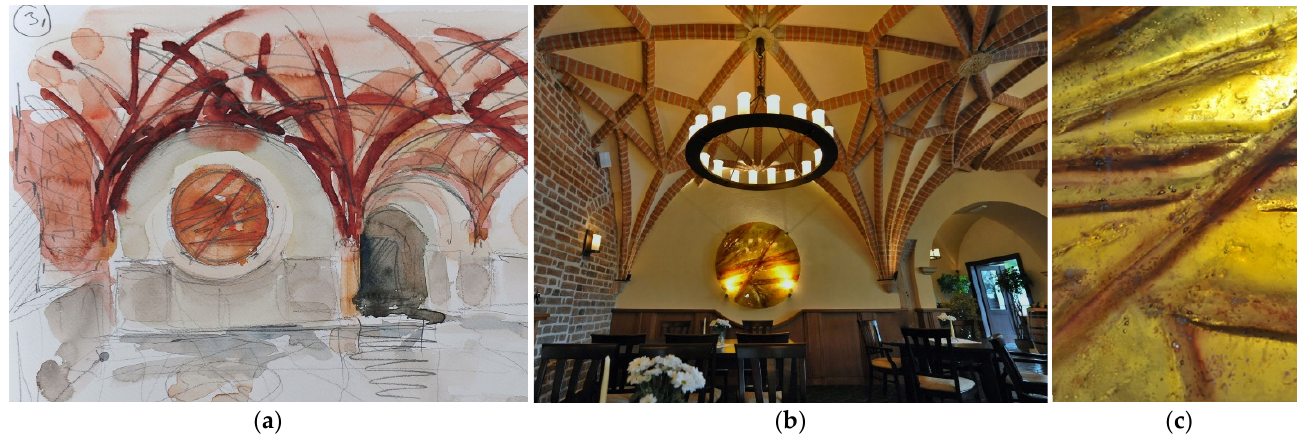
Figure 7. Glass composition by Tomasz Urbanowicz inspired by the stellar vault of the cellar’s interior of the town hall in Głogów, Poland, 2009: ( a ) watercolor design; ( b ) glass wall-art implementation; ( c ) detail of the use of color creating the effect referring to the character of the vault’s ribs (Tomasz Urbanowicz).